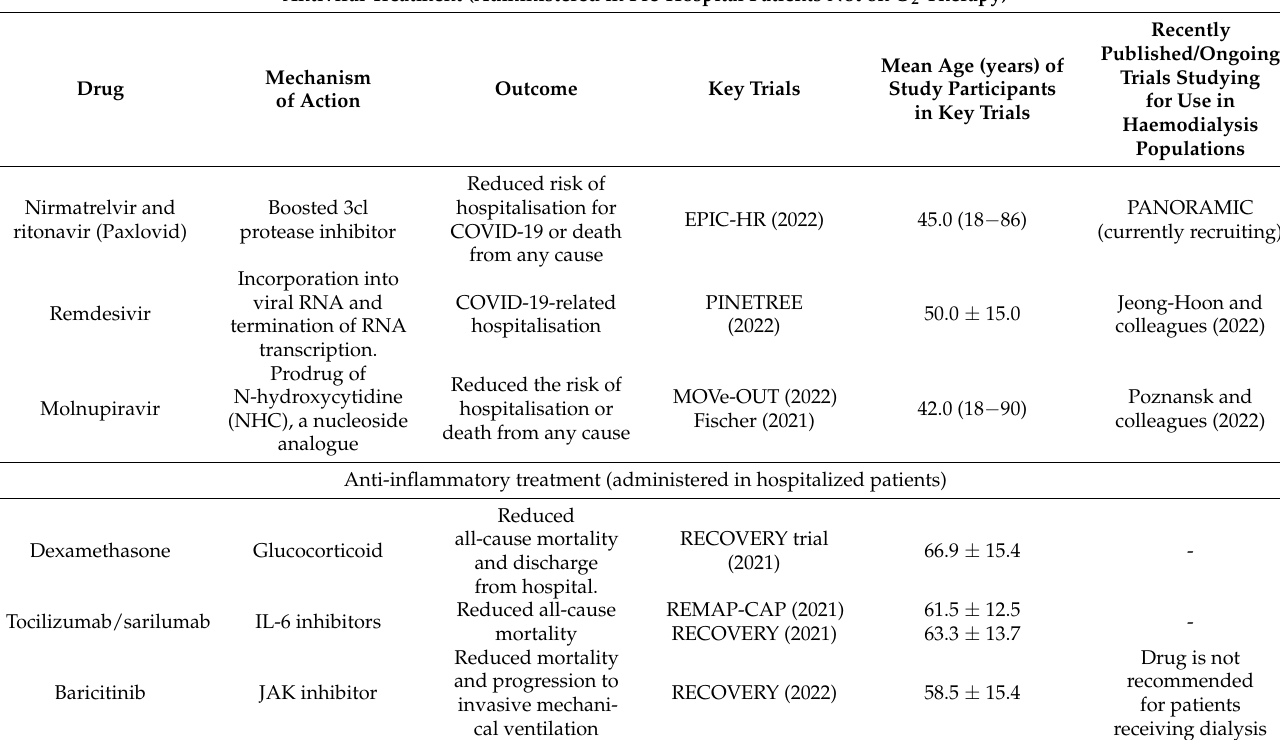
Table 1. Summary of potential antiviral and anti-inflammatory treatment options for elderly haemodialysis populations with